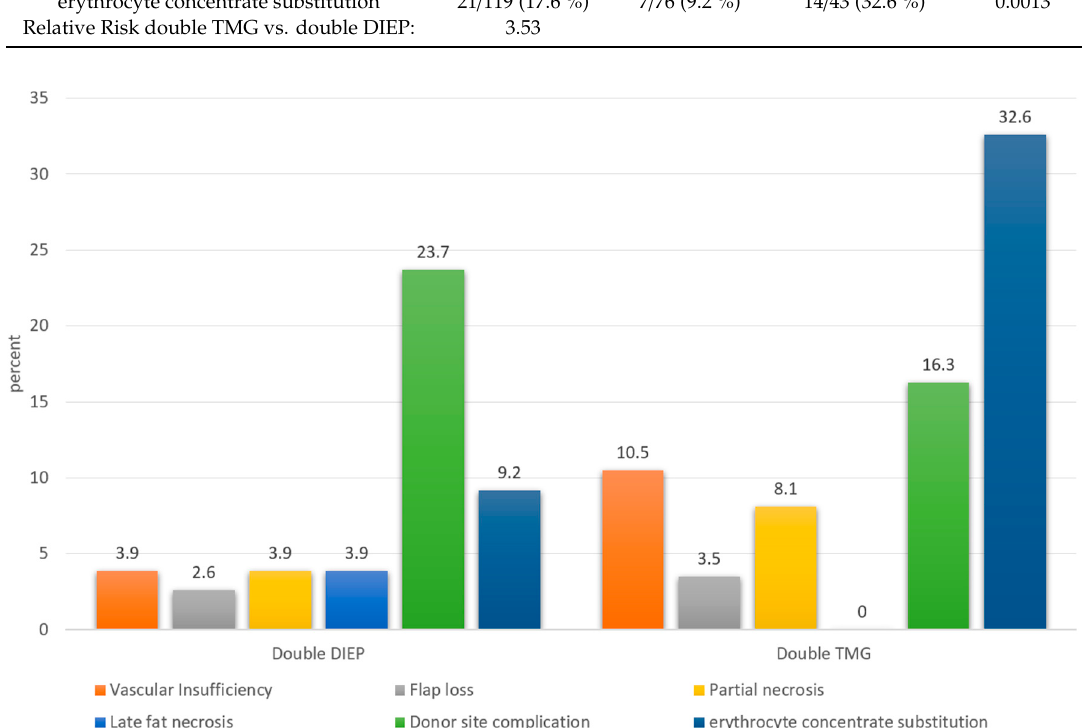
Figure 4. Categorized complications in the double DIEP and double TMG group.